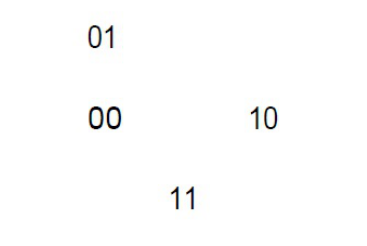
Fig. 2 Phase diagram of the